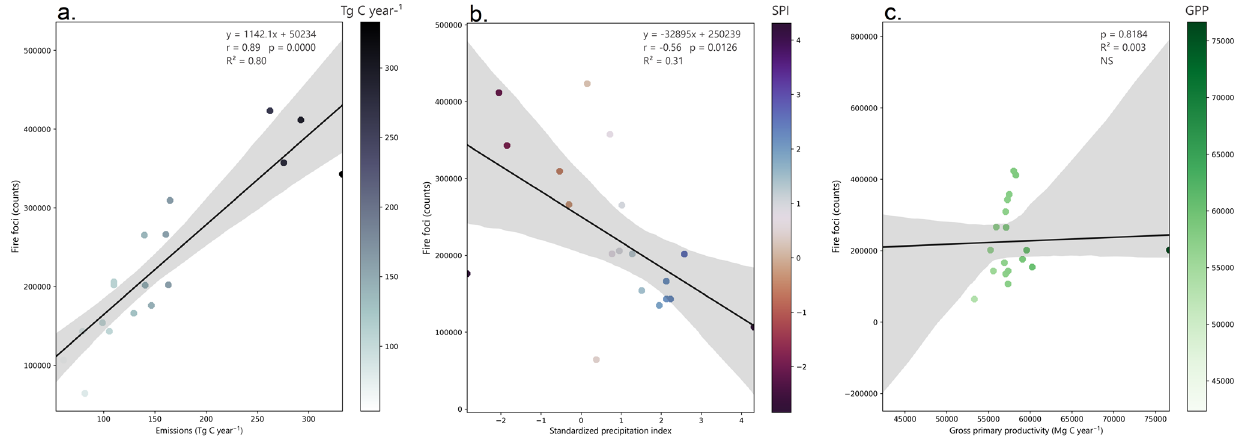
Figure 6. Correlation between variables emissions ( a ) standardized precipitation index (SPI); ( b ) gross primary productivity (GPP); and ( c ) fire foci (counts), followed by the coefficients of agreement (R 2 ), Pearson (r) values, and p -values.